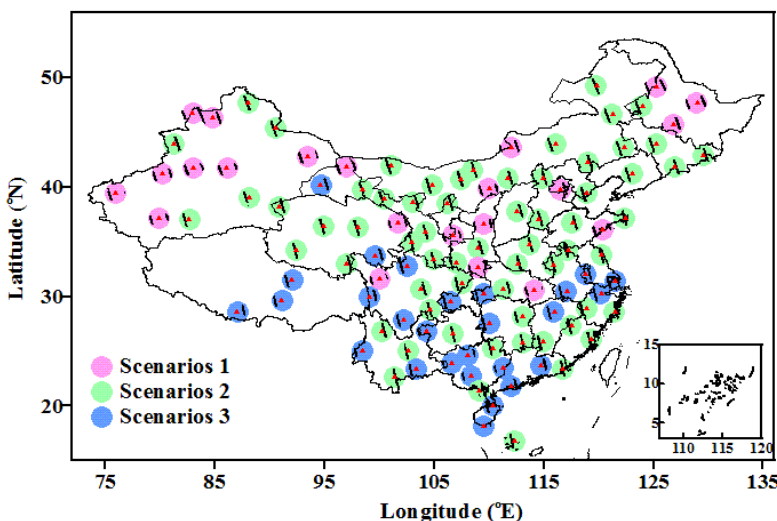
Figure 6. The geographic distribution map showing the location of radiosonde sites relative to CALIOP ground tracks over China. The red triangles denote the radiosonde sites, and the black lines show CALIOP tracks chosen for comparison analysis. The solid circles in cyan, green, and blue correspond to scenarios 1, 2, and 3 as defined in Fig. 5.